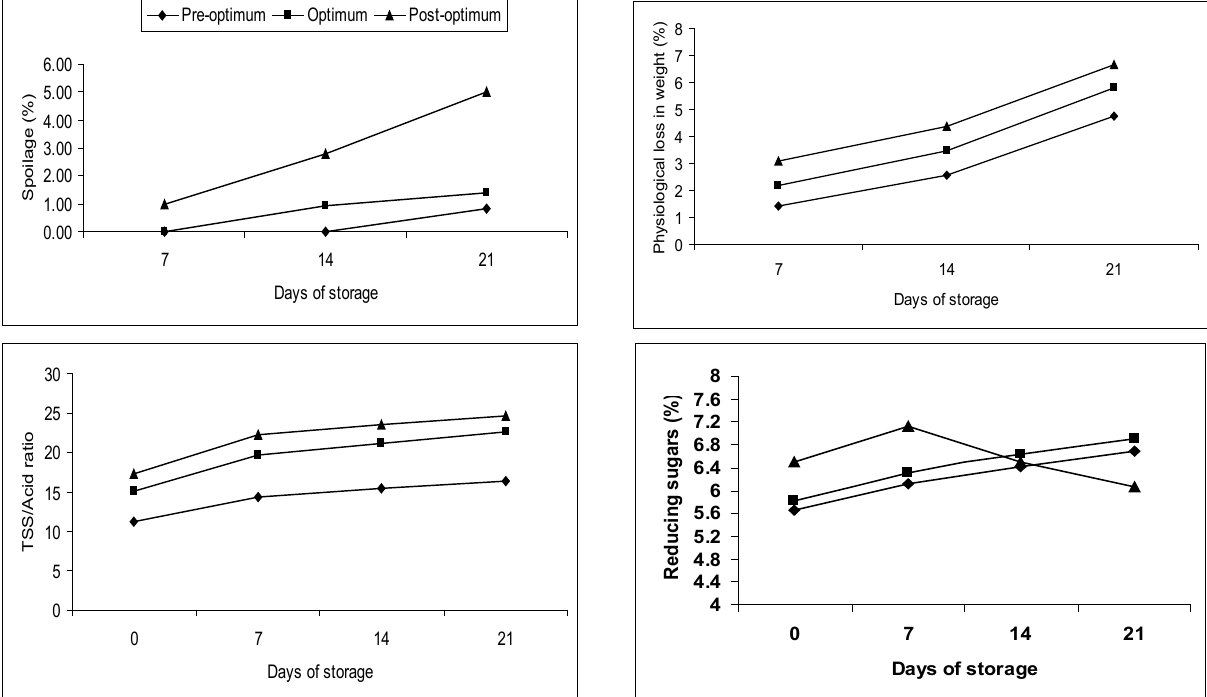
Fig . 1. Effect of harvesting stage on the spoilage percentage , physiological loss in weight, TSS/Acid ratio and reducing sugars (%) of peach fruits during cold